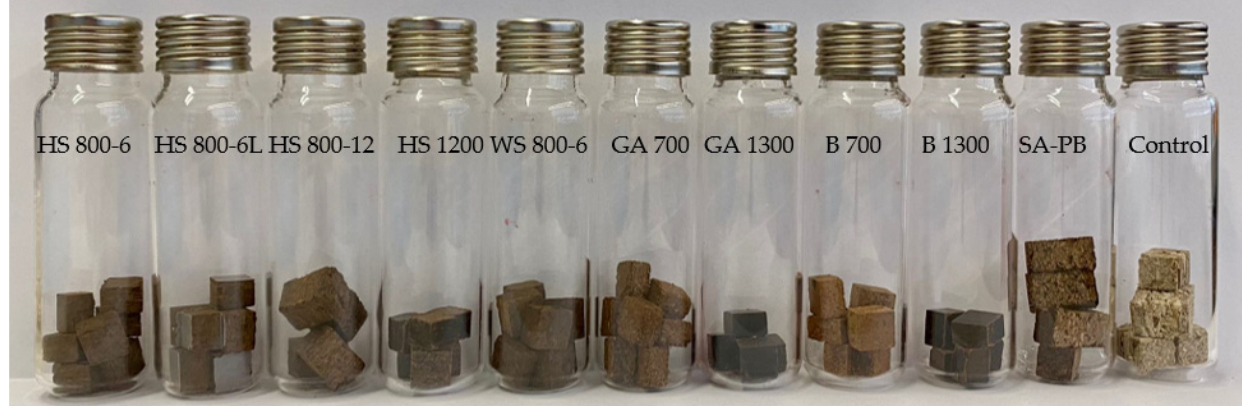
Figure 1. Weighed board specimens in closed vials.